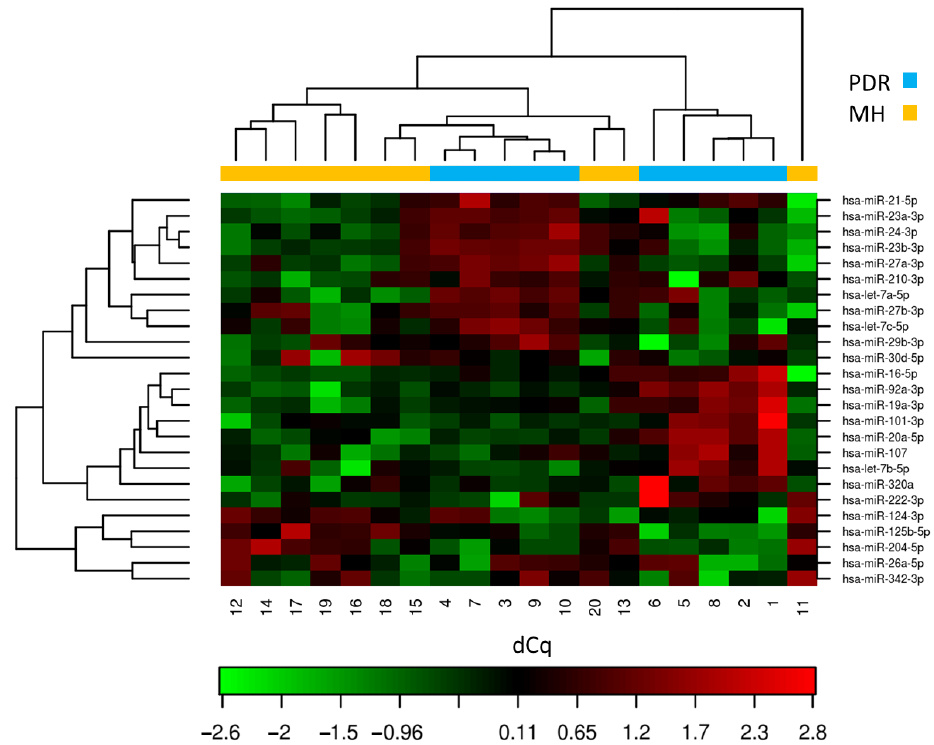
Figure 1. Heat map and the result of the two-way hierarchical clustering of miRNAs and samples.